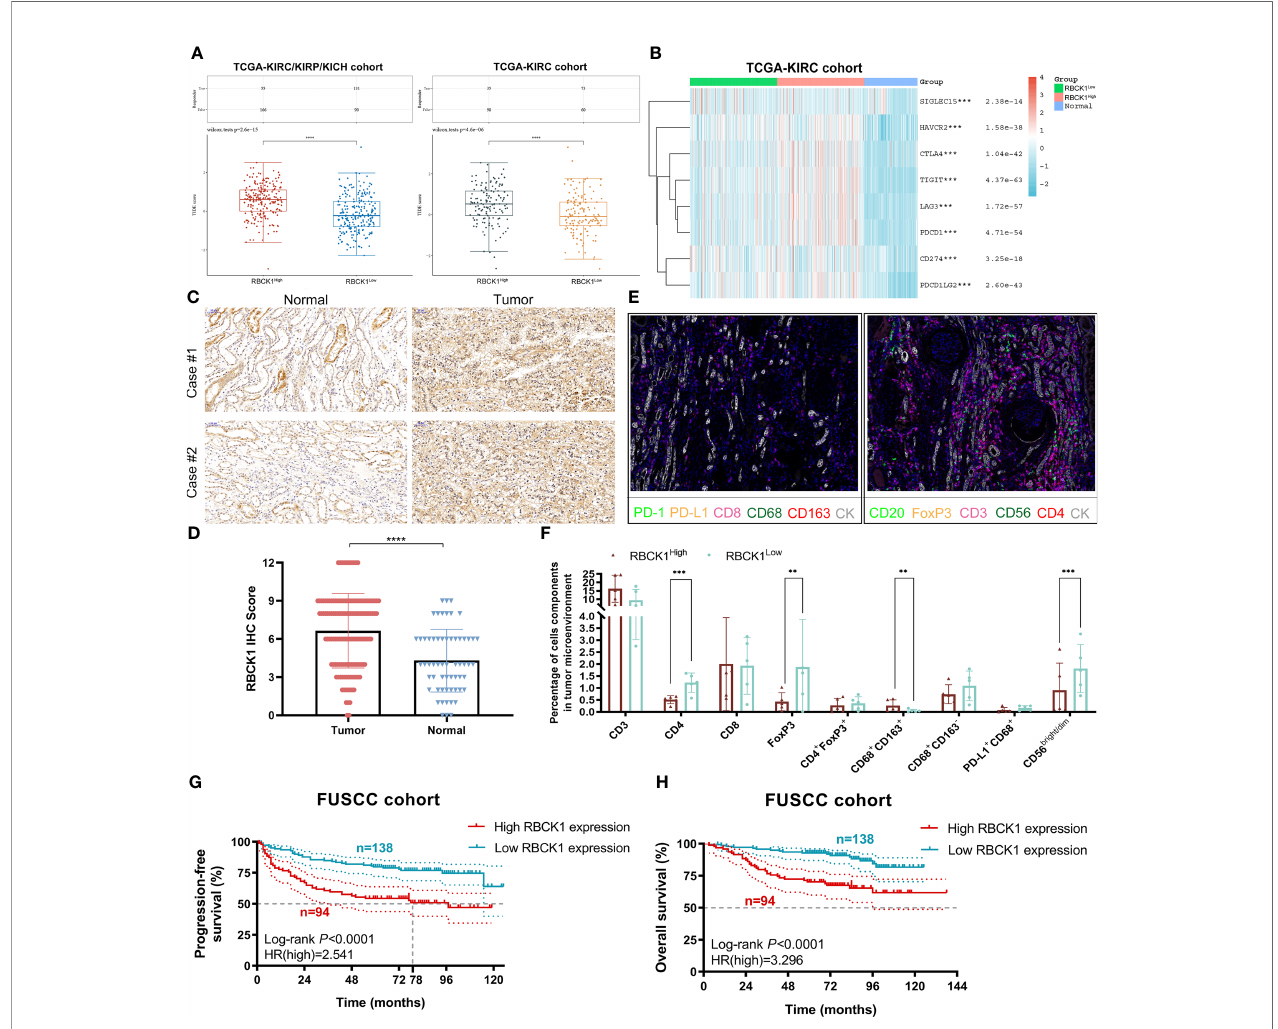
FIGURE 9 | Immunotherapy ef fi cacy, TIME characterization, and prognostic implications of RBCK1 in ccRCC patients from the Fudan University Shanghai Cancer Center (FUSCC) proteomics cohort. (A) The TIDE algorithm is used to evaluate two different tumor immune escape mechanisms and was developed in RBCK1 high compared with low RBCK1 expression group in both ccRCC and RCC cohorts using Student ’ s t -test. (B) The expression heatmap of immune checkpoint-related genes and RBCK1 in ccRCC and normal tissues was tested by Kruskal – Wallis, and the different colors represent the expression trend in different samples. (C, D) Immunohistochemistry staining showed RBCK1 expression in tumor ( n = 50) and normal kidney samples ( n = 40) from a real-world cohort, FUSCC, Shanghai. (E, F) Opal multi-marker immunohistochemistry was used on 10 ccRCC specimens to achieve six biomarker staining. The signi fi cance of the two groups of samples passed the Wilcoxon test. (G, H) Prognostic value of RBCK1 in predicting prognosis was assessed for 232 ccRCC patients from the FUSCC cohort based on proteomics sequencing data using the Kaplan – Meier method (** p < 0.01, *** p < 0.001, **** p <